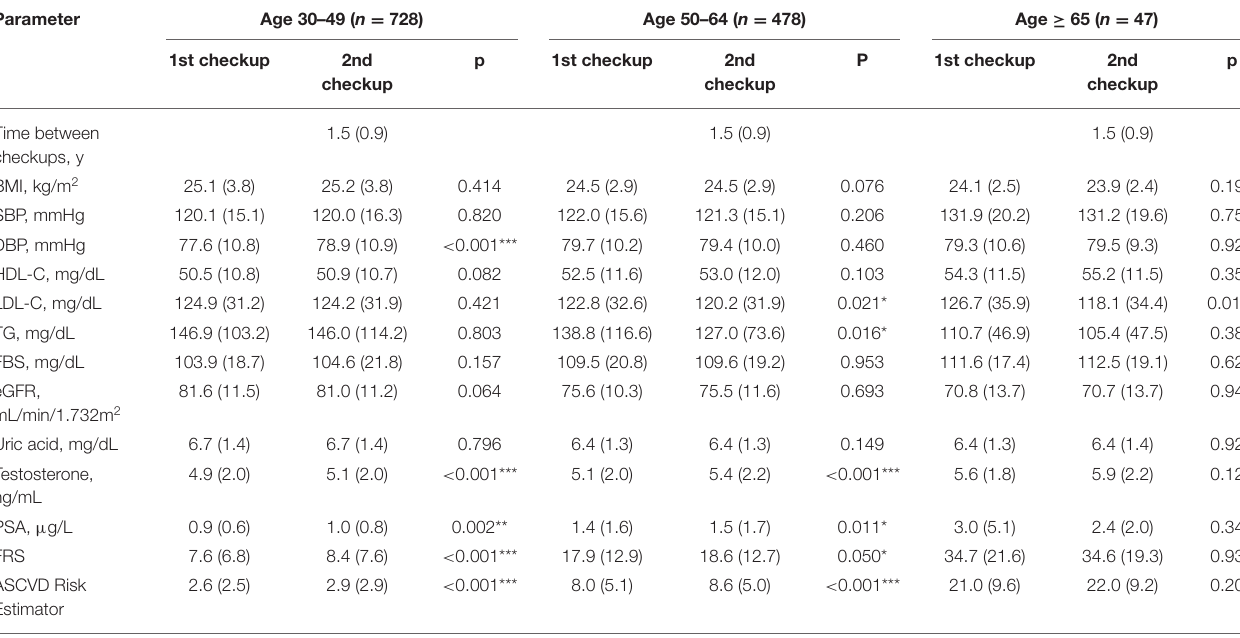
TABLE 1 | Comparison of the clinical characteristics of the study group according to